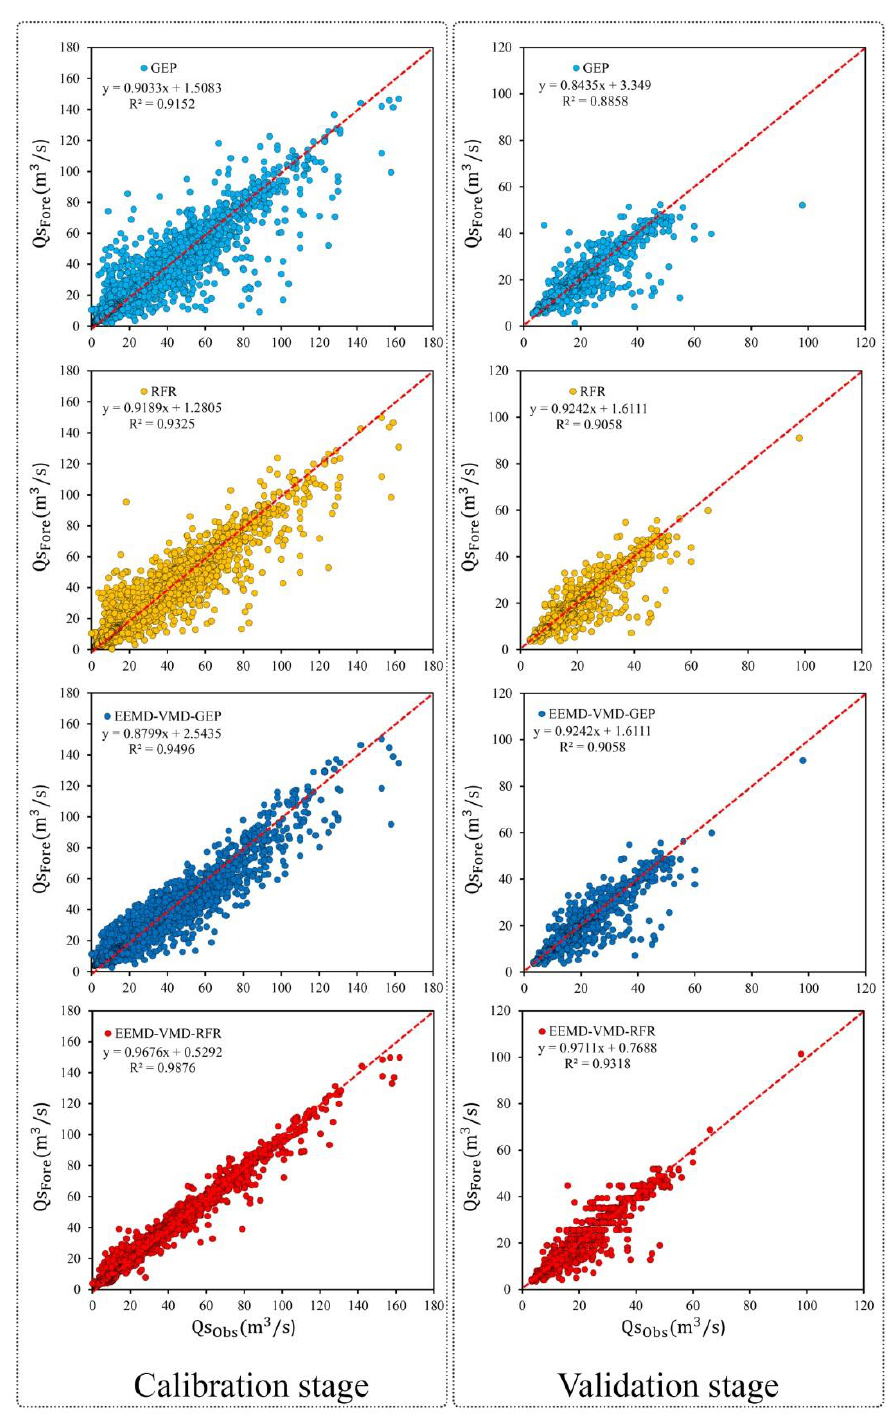
Figure 9. Scatterplot of forecasted (Qs) and observed (Qs) daily streamflow using the standalone GEP, RFR, and ensemble EEMD-VMD-GEP, EEMD-VMD-RFR models for the calibration and validation stages at the Bilghan station.